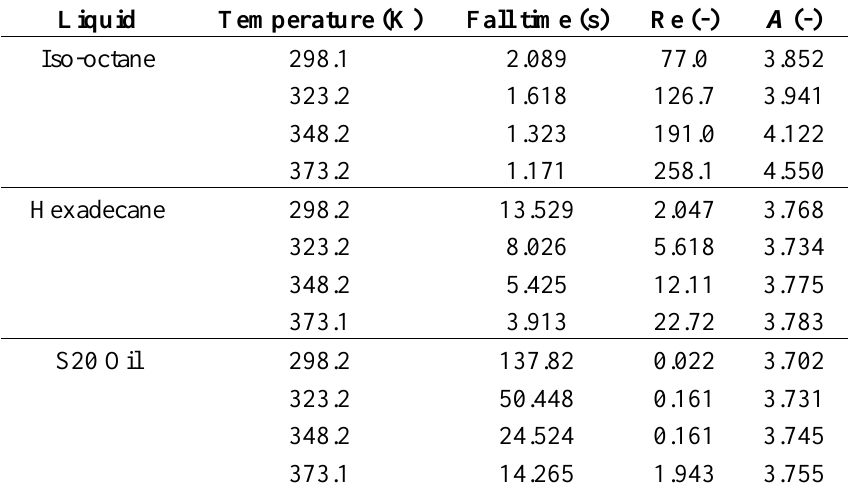
Table 1. Viscometer